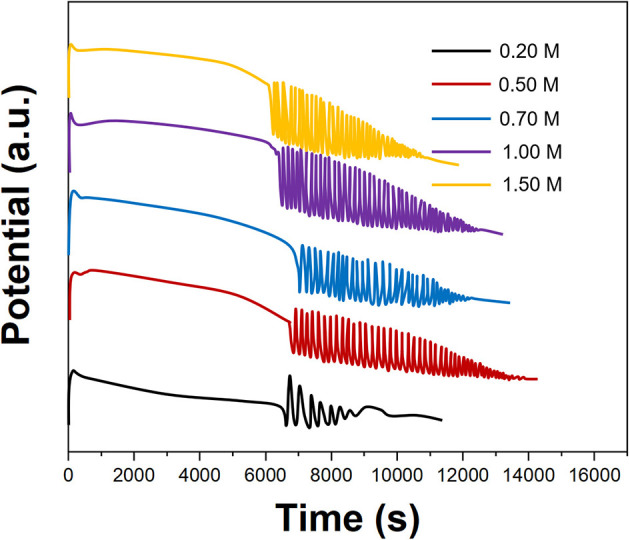
Oscillating profiles of Prunus persica recorded using different concentrations of CH3COCH3.